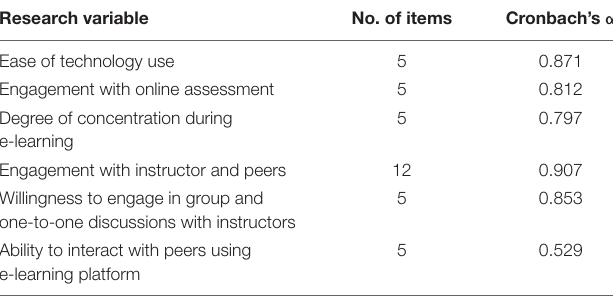
TABLE 1 | Reliability test of the questionnaire